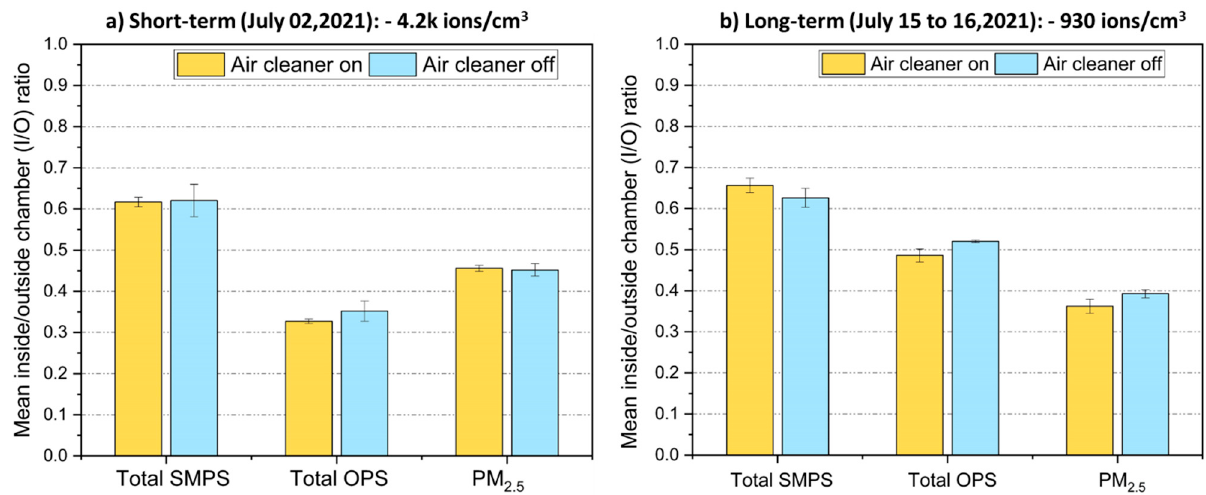
Figure 6. Mean (SD) inside/outside (I/O) chamber concentration ratios measured for three particle metrics (total SMPS number, total OPS number, and estimated PM 2.5 mass concentrations) during two natural condition tests: ( a ) short-term (2 July 2021) and ( b ) long-term (15–16 July 2021).